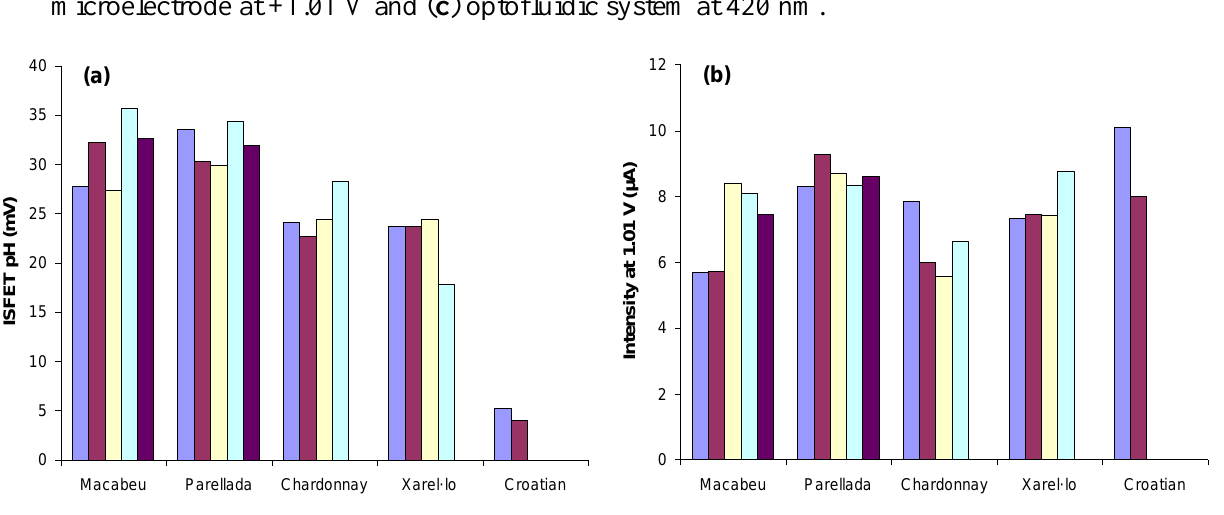
Figure 3. Response of sensors for the 20 monovarietal wines: ( a ) pH ISFET, ( b ) Au microelectrode at +1.01 V and ( c ) optofluidic system at 420